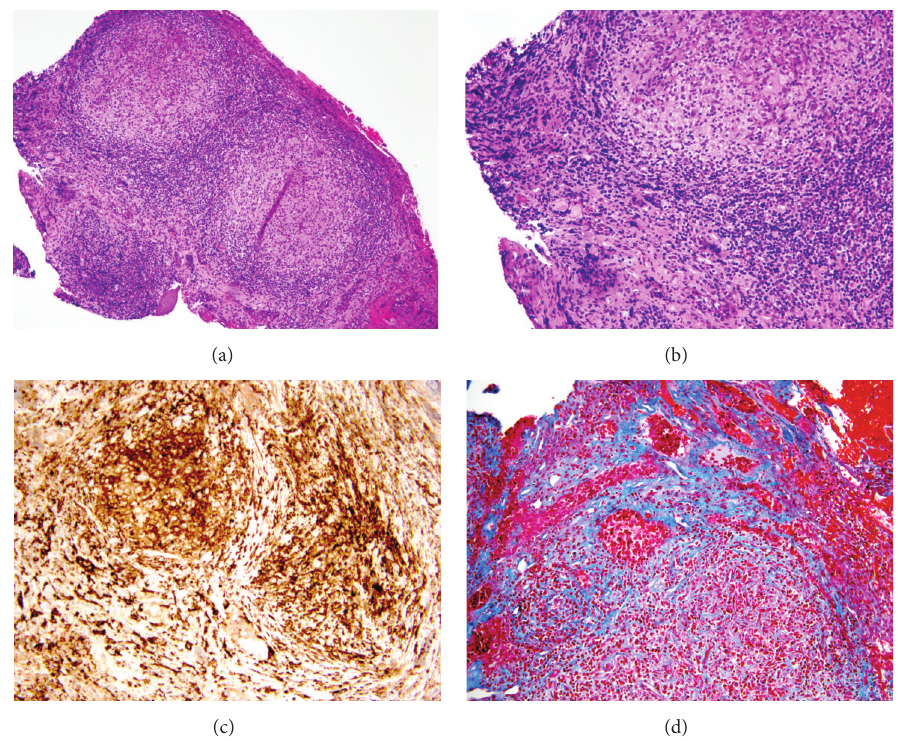
Figure 2: (a) A low magnification view of the sellar region showing multiple granulomas composed of histiocytes surrounded by lympho- plasmacystic infiltrates, 100x. (b) A higher magnification view of the granulomatous inflammation, 400x. (c) CD163 immunohistochemical stain highlighting the histiocytes within the granulomas, 400x. (d) Trichrome histochemical stain highlighting background fibrosis in blue,